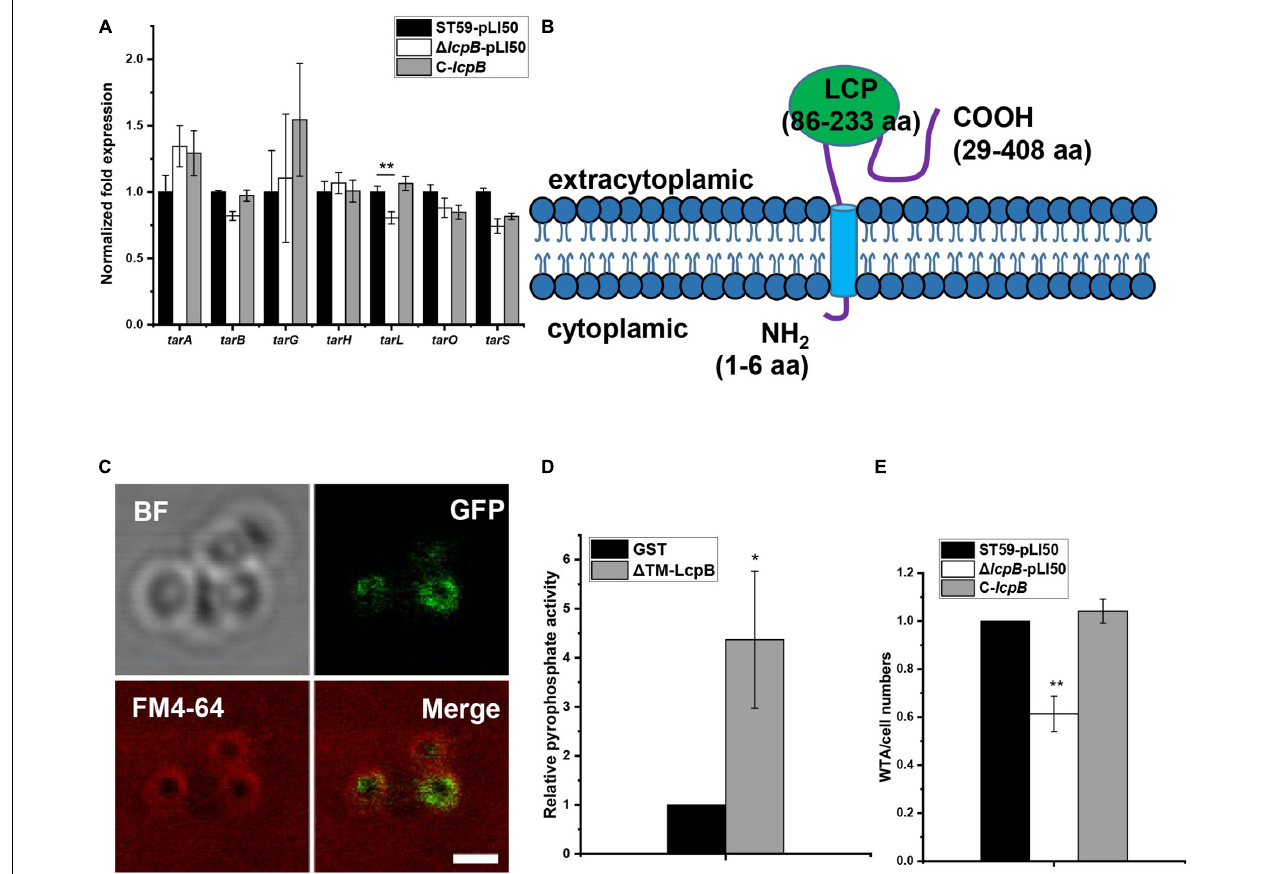
FIGURE 2 | LcpB has pyrophosphatase activity and affects WTA synthesis. (A) The transcription levels of genes related to cell wall synthesis in the wild-type, lcpB mutant, and complemented strains were evaluated through RT-qPCR. The means and standard deviations were then calculated. Data is presented as the mean ± standard deviations. Two-tailed Student’s t -test is used for the comparison of statistical significance. The wild-type strain was used as the reference. * p < 0.05; ** p < 0.01. (B) The putative structure of LcpB. (C) LcpB-GFP localized to the cell membrane. LcpB, labeled by GFP, was co-localized with the cell membrane, indicated by FM4-64. The scale bar is 1 µ m. (D) The pyrophosphatase activity of (cid:49) TM-LcpB. Truncated LcpB (4 µ g) purified using a GST tag was incubated with 2 µ mol FPP for 1 h at 30 ◦ C and GST with FPP was used as a control. The results were obtained from three independent experiments performed in triplicates, after which the means and standard deviations were calculated. Data is presented as the mean ± standard deviations. Two-tailed Student’s t -test is used for the comparison of statistical significance. * p < 0.05. (E) Quantification of WTA in the wild-type, lcpB mutant, and complemented strains. At least three independent experiments were performed for each assay, after which the means and standard deviations were calculated. Data is presented as the mean ± standard deviations. Two-tailed Student’s t -test is used for the comparison of statistical significance. * p < 0.05; ** p <